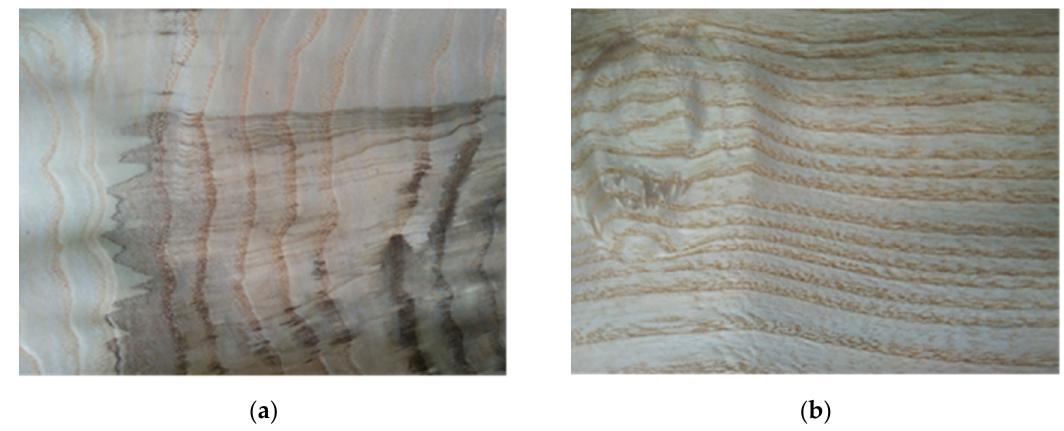
Figure 1. Dead knots in oak wood sliced plain-cut veneer ( a ), and in chestnut wood sliced veneer ( b ).